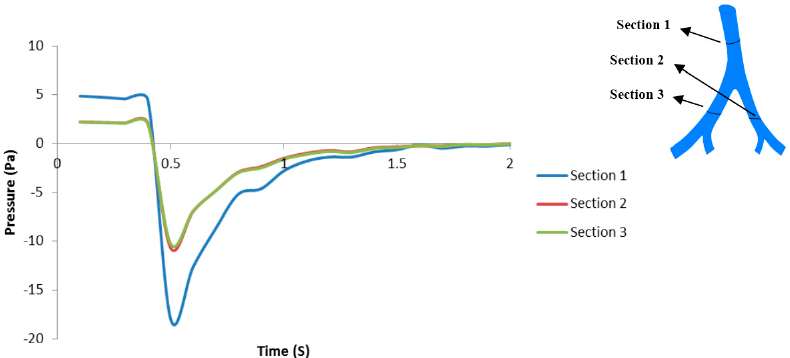
Figure 3. Average transient pressure for MV breathing in Sections 1–3 obtained from airflow simulation.